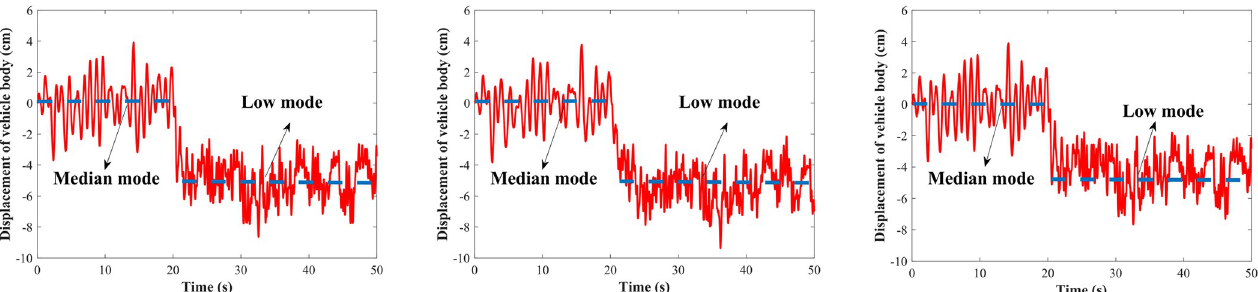
Fig 19. Median mode to low mode under the random road. (A) 20 m/s; (B) 30 m/s; (C) 40 m/s.